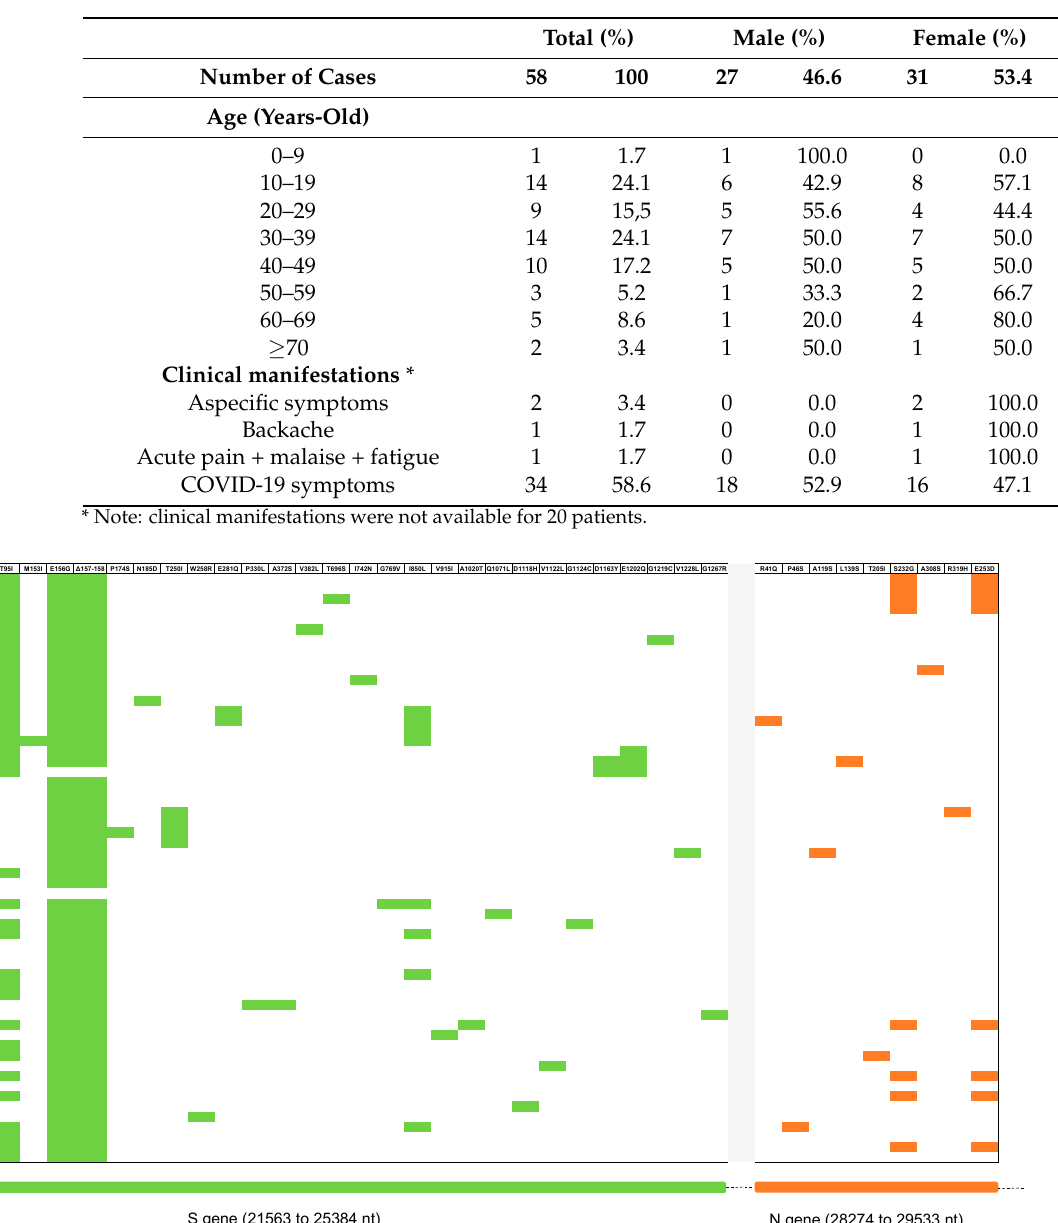
Table 1. Patients’ characteristics at SARS-CoV-2 diagnosis.